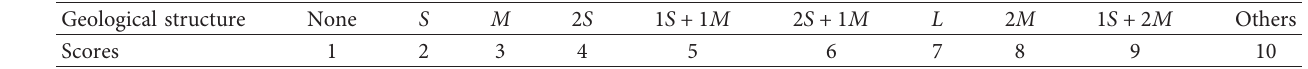
Table 11: The scores of geological structures.